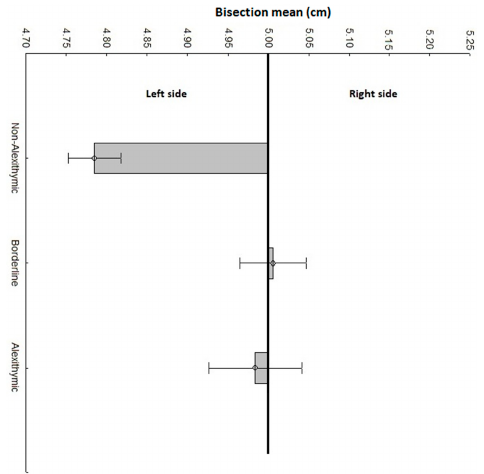
Figure 1. Performance in the line bisection task of alexithymic, borderline, and non-alexithymic participants. Deviations from the central vertical line indicate the mean bisection shift of the three groups of participants for the 10-cm segment. Scores less than 5 cm indicate a deviation to the left (i.e., pseudoneglect). Scores greater than 5 cm indicate a deviation to the right. Vertical bars indicate standard error. Correlation analysis provided further support to the ANOVA results. We found a positive correlation between TAS-20 and line bisection scores ( r = 0.329, p < 0.001). There- fore, the higher the TAS-20 score, the larger the rightward shift in the line bisection task (Figure 2).